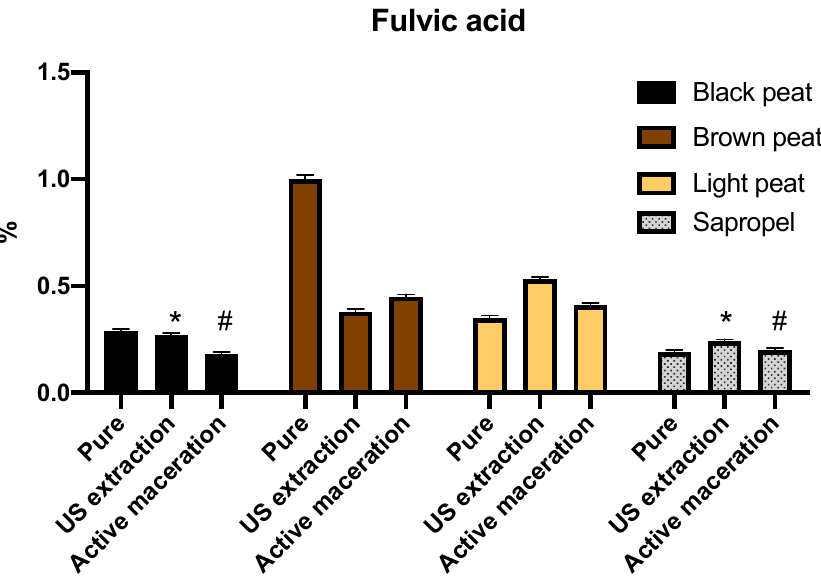
Figure 2. Fulvic acid amount (percentage of total compound distribution) determined in the pure peat, in the extracts after ultrasound-assisted extraction and active maceration. *—Values with p = 0.1217; #—values with p = 0.2254; all other values with p < 0.05.